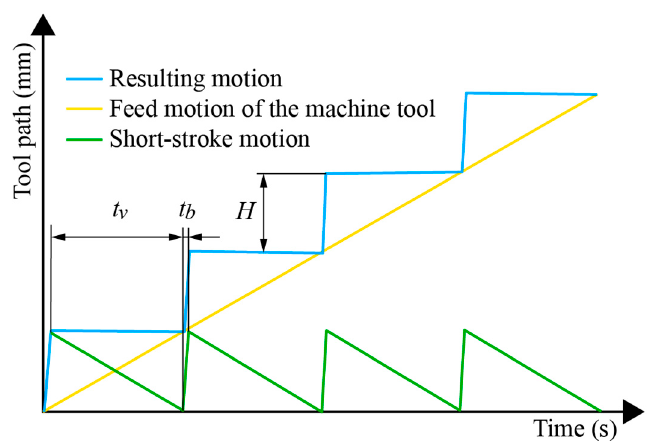
Figure 2. Resulting tool path during SST.